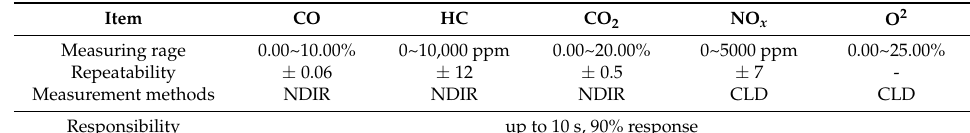
Table 7. Specifications of the exhaust gas measuring device.